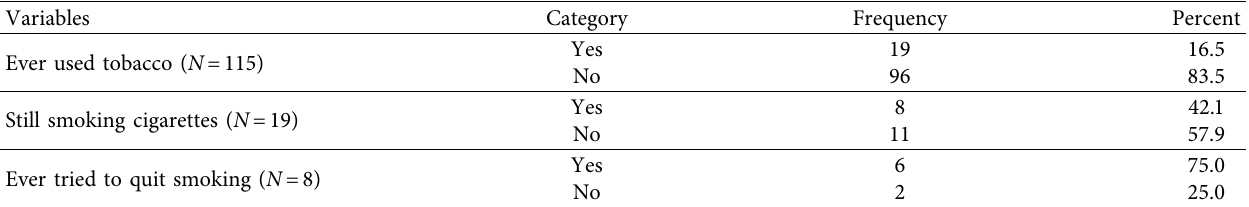
Table 5: Adherence to cessation of smoking among hypertensive patients in a follow-up clinic of Asella Referral and Teaching Hospital, Asella Town, Arsi Zone, Oromia Regional State, Ethiopia, 2020 ( n � 115). Variables